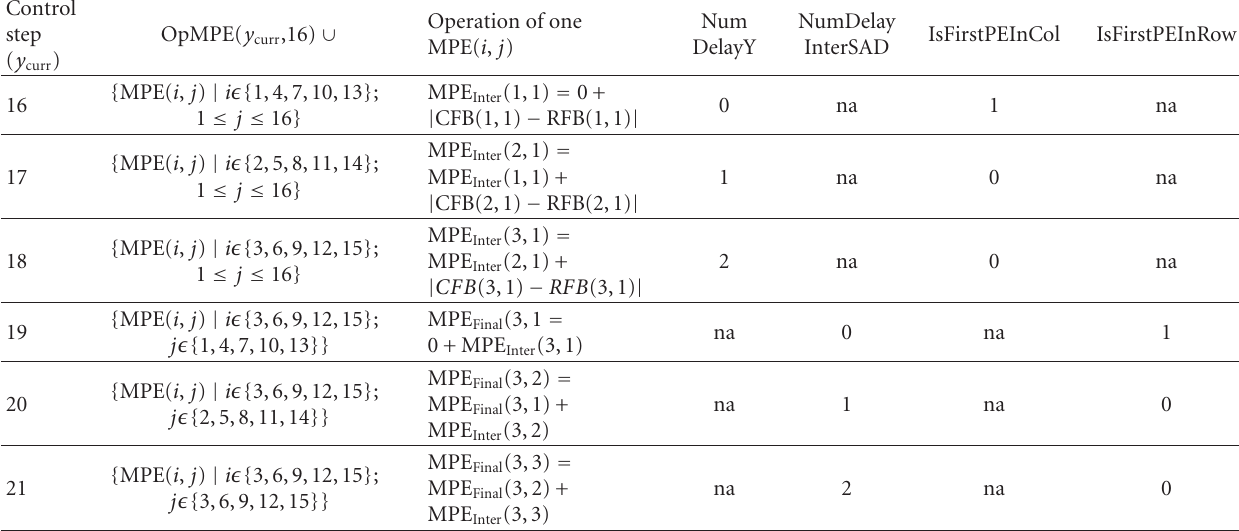
Table 5: Illustration of the MPESA operation for block size (3 × 3) on the first set of candidate